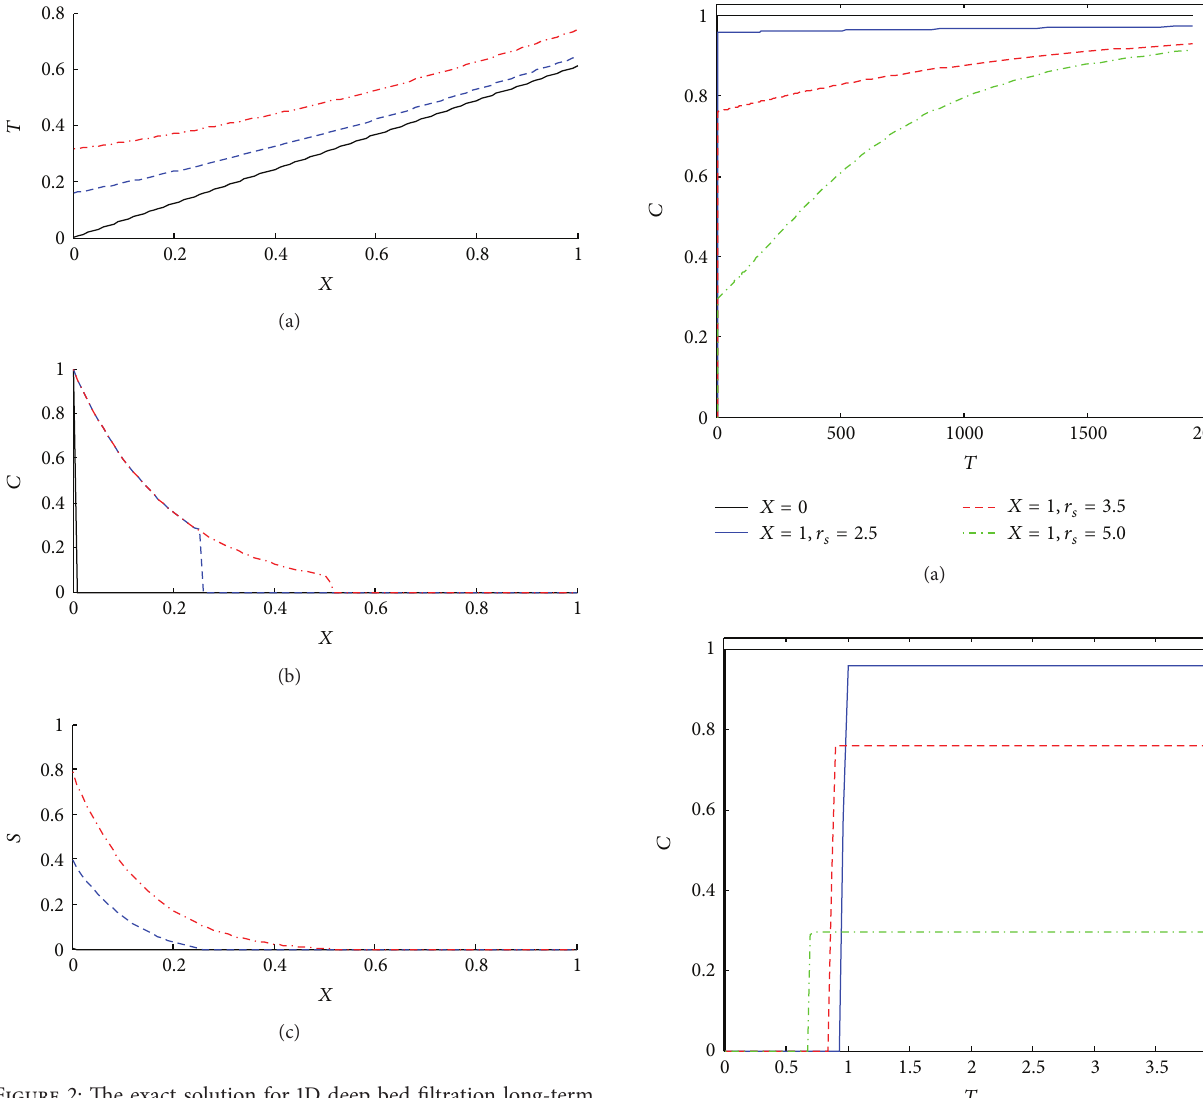
Figure 2: The exact solution for 1D deep bed filtration long-term injection problem: (a) characteristic lines and the concentration front in ( X,T )-plane; (b) shock front in the suspended concentration profile; (c) continuous retention concentration profile.